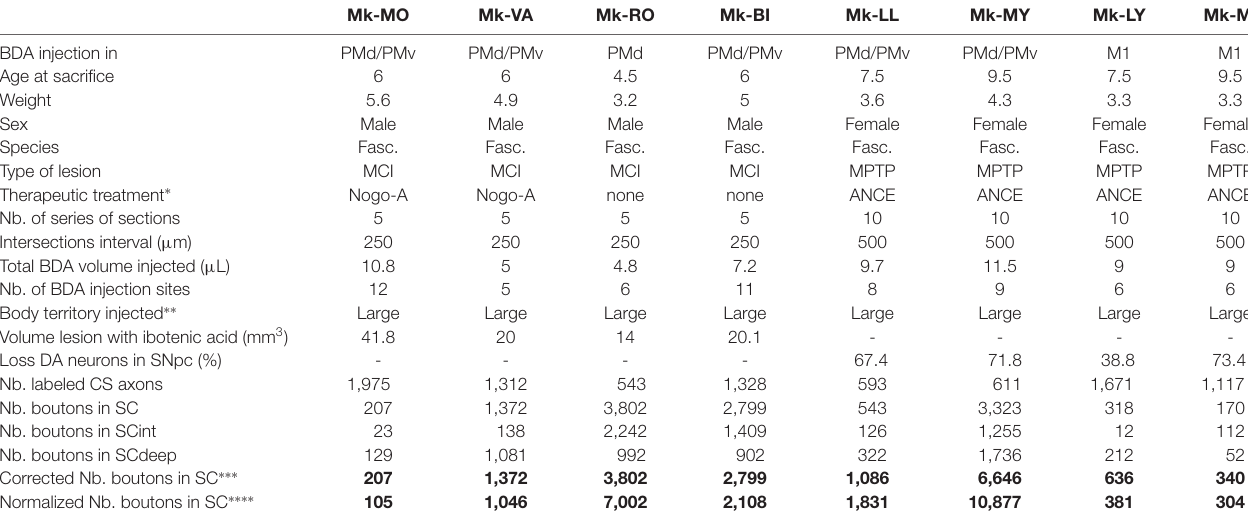
TABLE 1 | Individual data for the eight monkeys included in the present